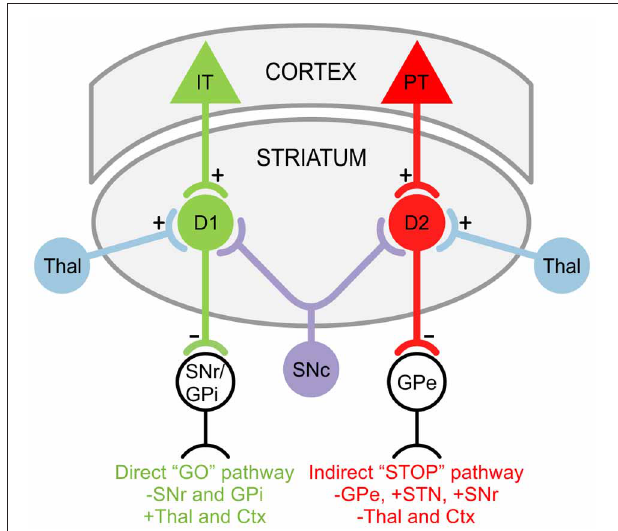
FIGURE 1 | Striatal projection pathways. In the direct “GO” pathway, MSNs expressing DA D1 receptors receive inputs from intratelencephalically projecting (IT) neurons in the cortex (Ctx) and project to the substantia nigra pars reticulata (SNr) as well as the internal segment of the globus pallidus (GPi). In the indirect “STOP” pathway, MSNs expressing DA D2 receptors receive inputs from pyramidal tract (PT) neurons in the Ctx and project to the external segment of the globus pallidus (GPe). The GPe, in turn, projects to the STN and SNr. Both D1 and D2 MSNs also receive afferents from the substantia nigra pars compacta (SNc) and thalamus